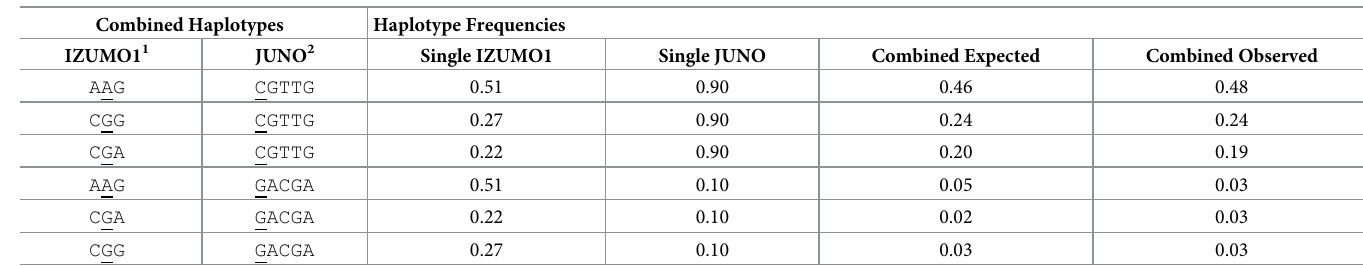
Haplotype frequencies for each individual gene are provided under “Single” columns. The frequency expected if assortment of cross-gene haplotypes is random (“Expected”) is compared to the frequency of both haplotypes appearing together as observed in the phased gene sequences analyzed (“Observed”). Underlined nucleotides correspond to missense mutations.